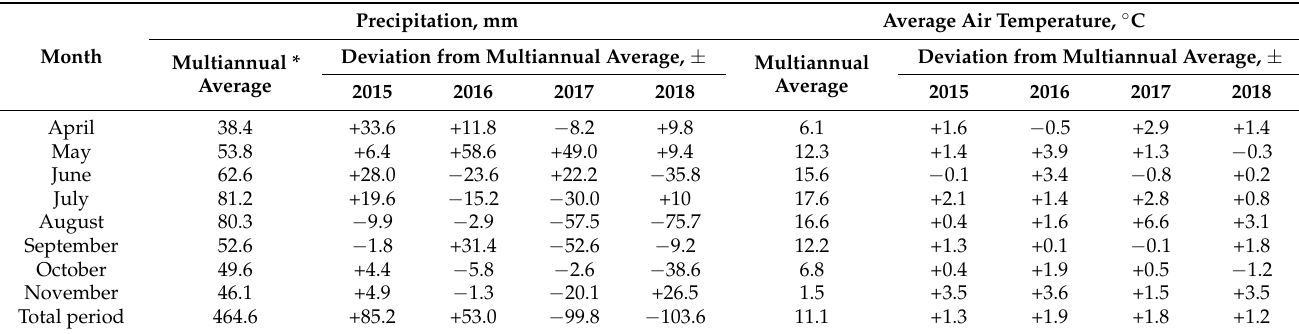
Table 2. Precipitation and average air temperature during the April–November period. Records of the iMETOS ® meteoro- logical station in